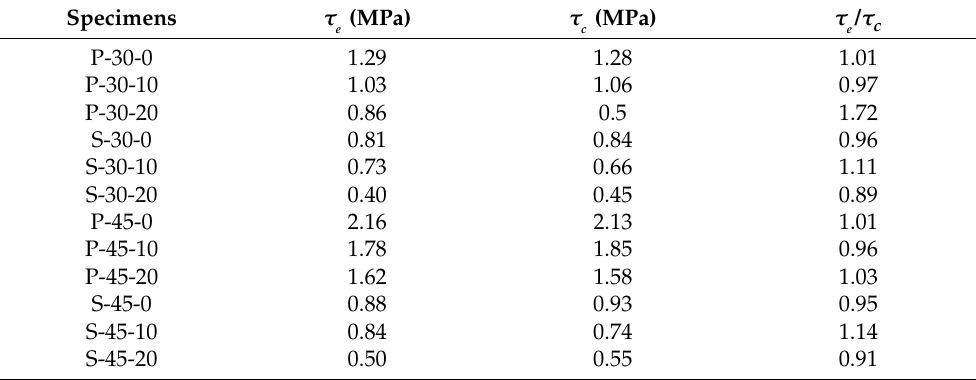
Table 5. Contrast between bond strength experimental values ( τ values ( τ c